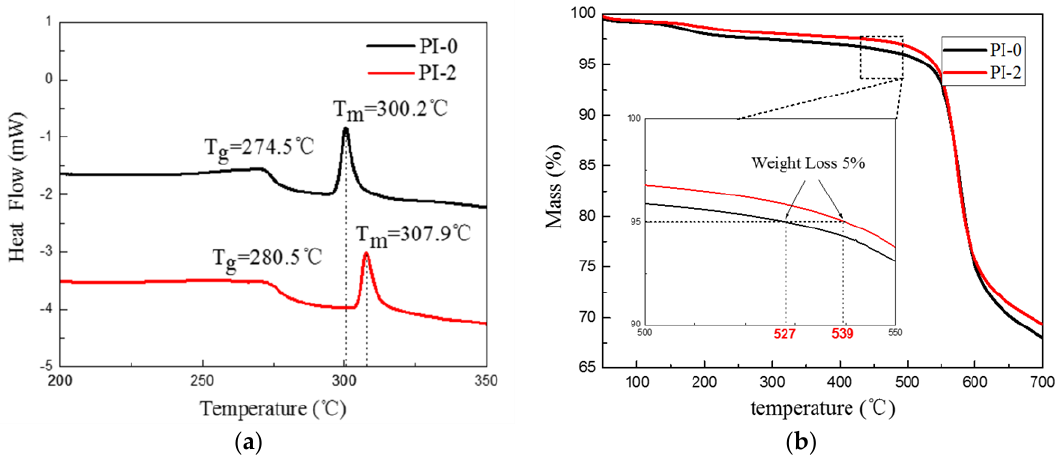
Figure 6. ( a ) DSC curves of PI-0 and PI-2; ( b ) TGA curves of PI-0 and PI-2.